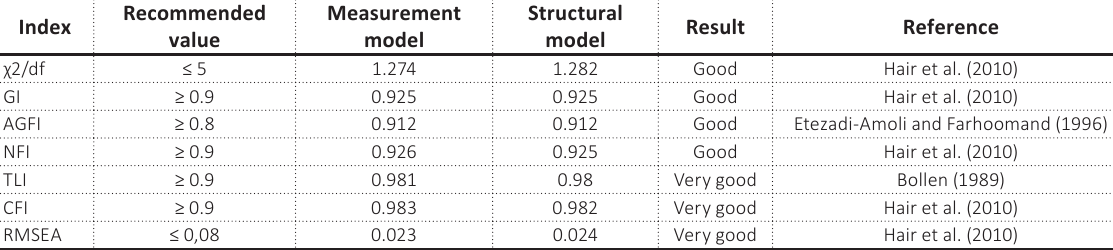
Table 4. Fit indices for measurement and structural models